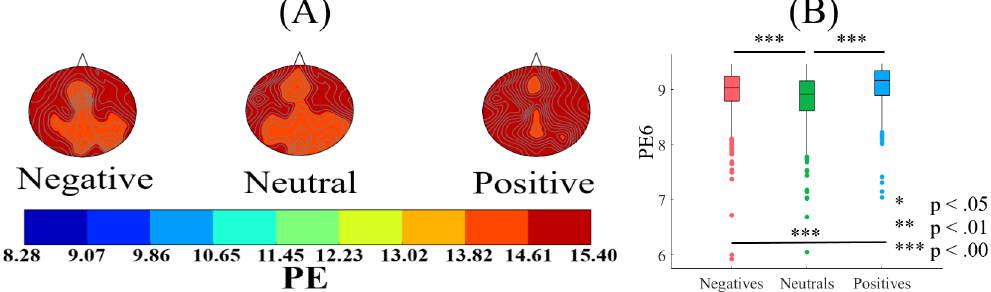
Figure A18. ( A ) Grand averages of the spatial maps of participants’ PE6s (i.e., 62 PE6s associated with 62 EEG channels of a participant, per affect) in negative, neutral, and positive mental states. The distribution of PE6s in these spatial maps corresponds to the EEG channels’ arrangement in Figure 1B in the main text (i.e., one PE6 value, per EEG channel). ( B ) Descriptive statistics of the posthoc Wilcoxon rank sum tests applied on participants’ whole-brain PE6s (i.e., 62 PE6s associated with 62 EEG channels of a participant, per